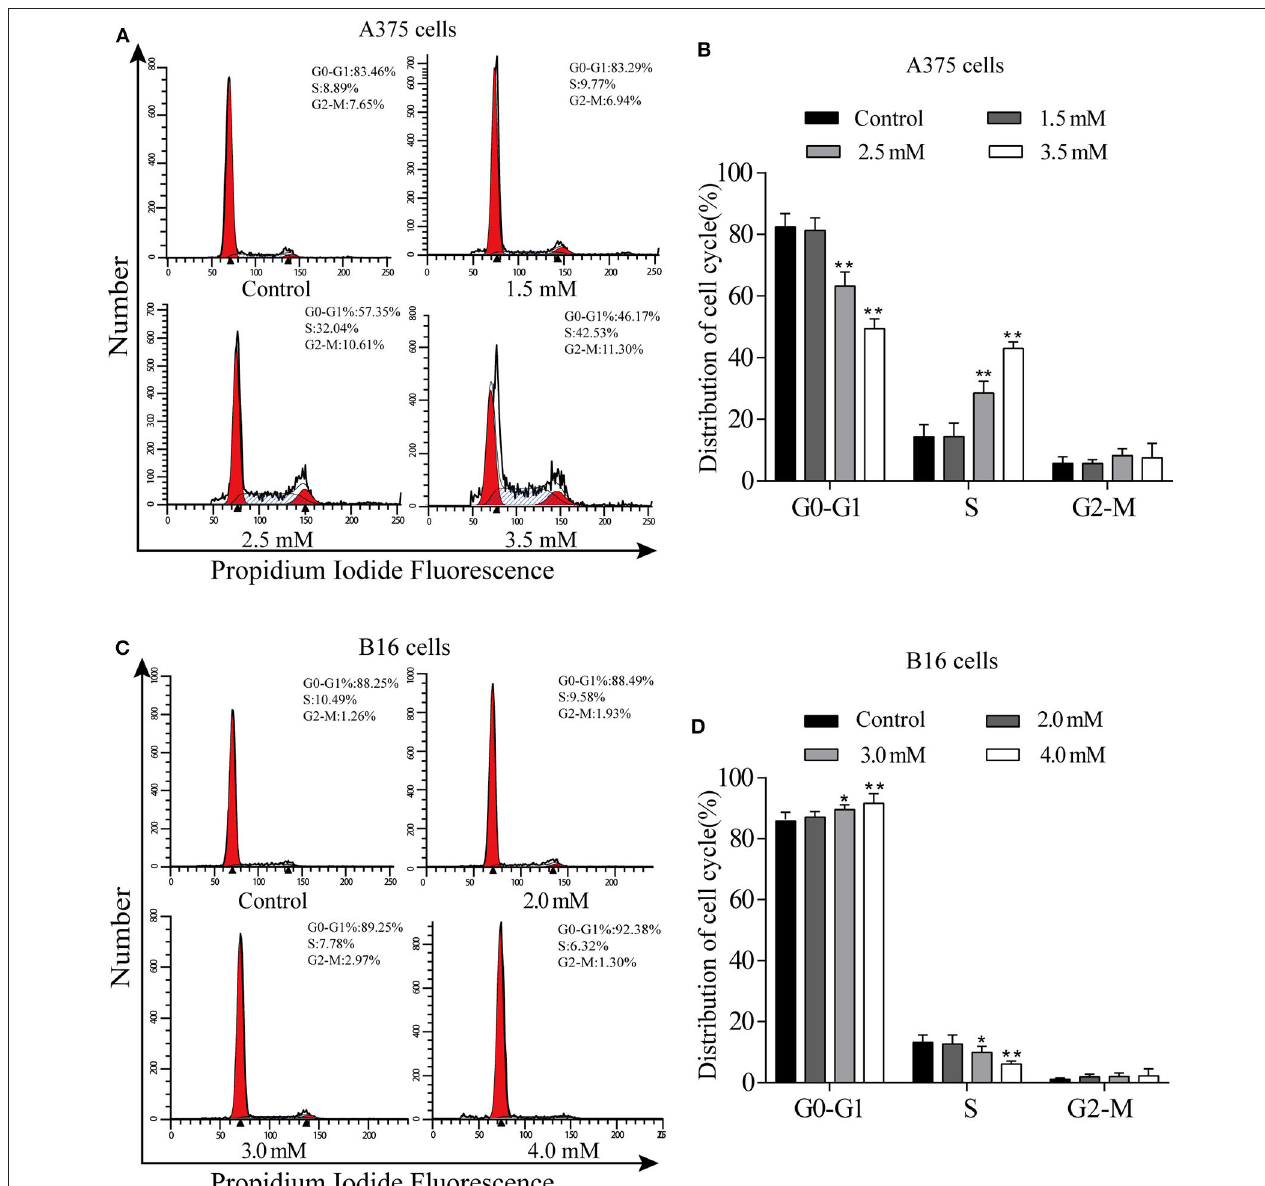
FIGURE 2 | p- CA causes A375 and B16 cell cycle arrest. (A) The cell cycle distribution of A375 cells treated with p- CA was measured by flow cytometry. (B) Statistical analysis of the cell cycle distribution of A375 cells treated with p- CA. (C) The cell cycle distribution of B16 cells treated with p- CA was measured by flow cytometry. (D) Statistical analysis of the cell cycle distribution of B16 cells treated with p- CA. All data are expressed as the mean ± SD of three independent experiments. * P < 0.05, ** P < 0.01 compared with the